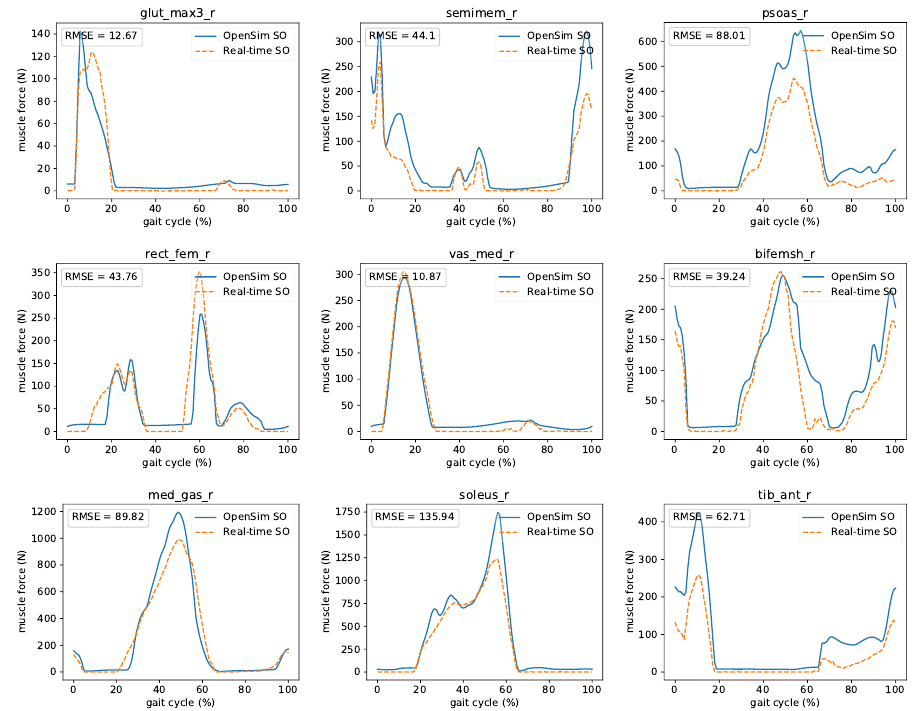
Figure 11. Comparison between OpenSim ’s SO and proposed real-time muscle optimization method. The force of major right leg muscles: gluteus maximus, semimembranosus, psoas major, rectus femoris, vastus medialis, biceps femoris short head, medial gastrocnemius, soleus, and tibialis anterior was presented.